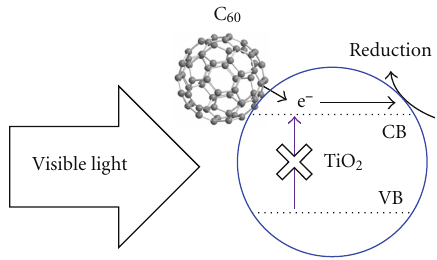
Scheme 2: Schematic illustration of the photogenerated electron transfer model of the TiO 2 -C 60 composite under visible light irradiation.